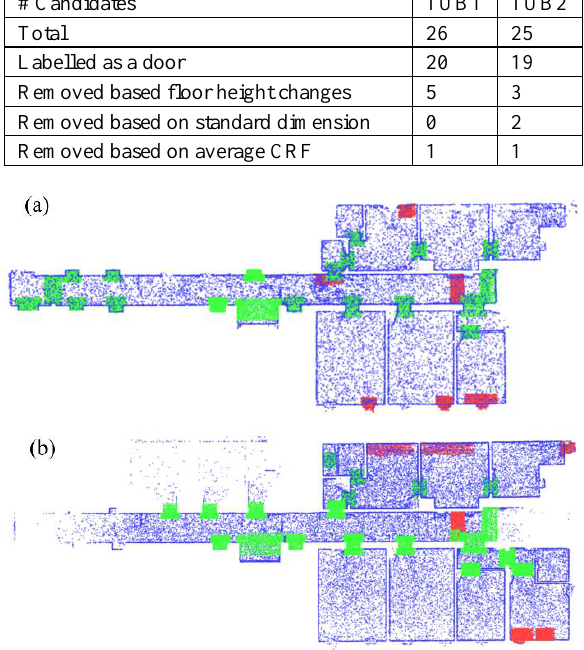
Figure 8. Candidate doors labelled as door or not-door. (a) TUB 1. (b) TUB 2